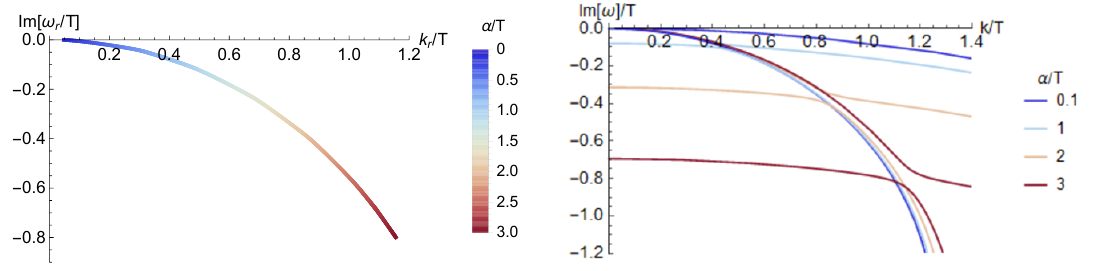
Figure 4 . The mode repulsion at di(cid:11)erent (cid:11)=T . Left: the repulsion point ( k r ; ! r ) for di(cid:11)erent (cid:11)=T at (cid:22)=T (cid:28) 1. Similar behaviour appears for di(cid:11)erent (cid:22)=T . Right: dispersion relations highlighting gap opening at (cid:22)=T = 0 : 1 near some repulsion points of the left panel.